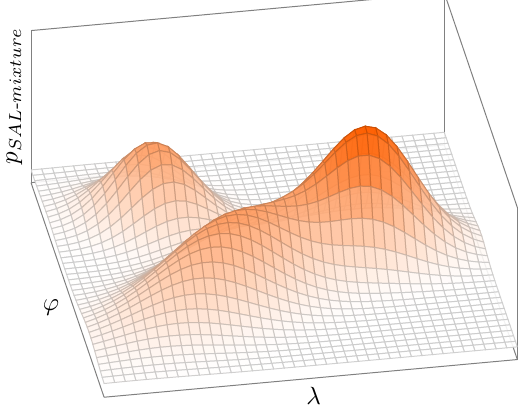
Figure 2. A mixture mode with three weighted Gaussian components.